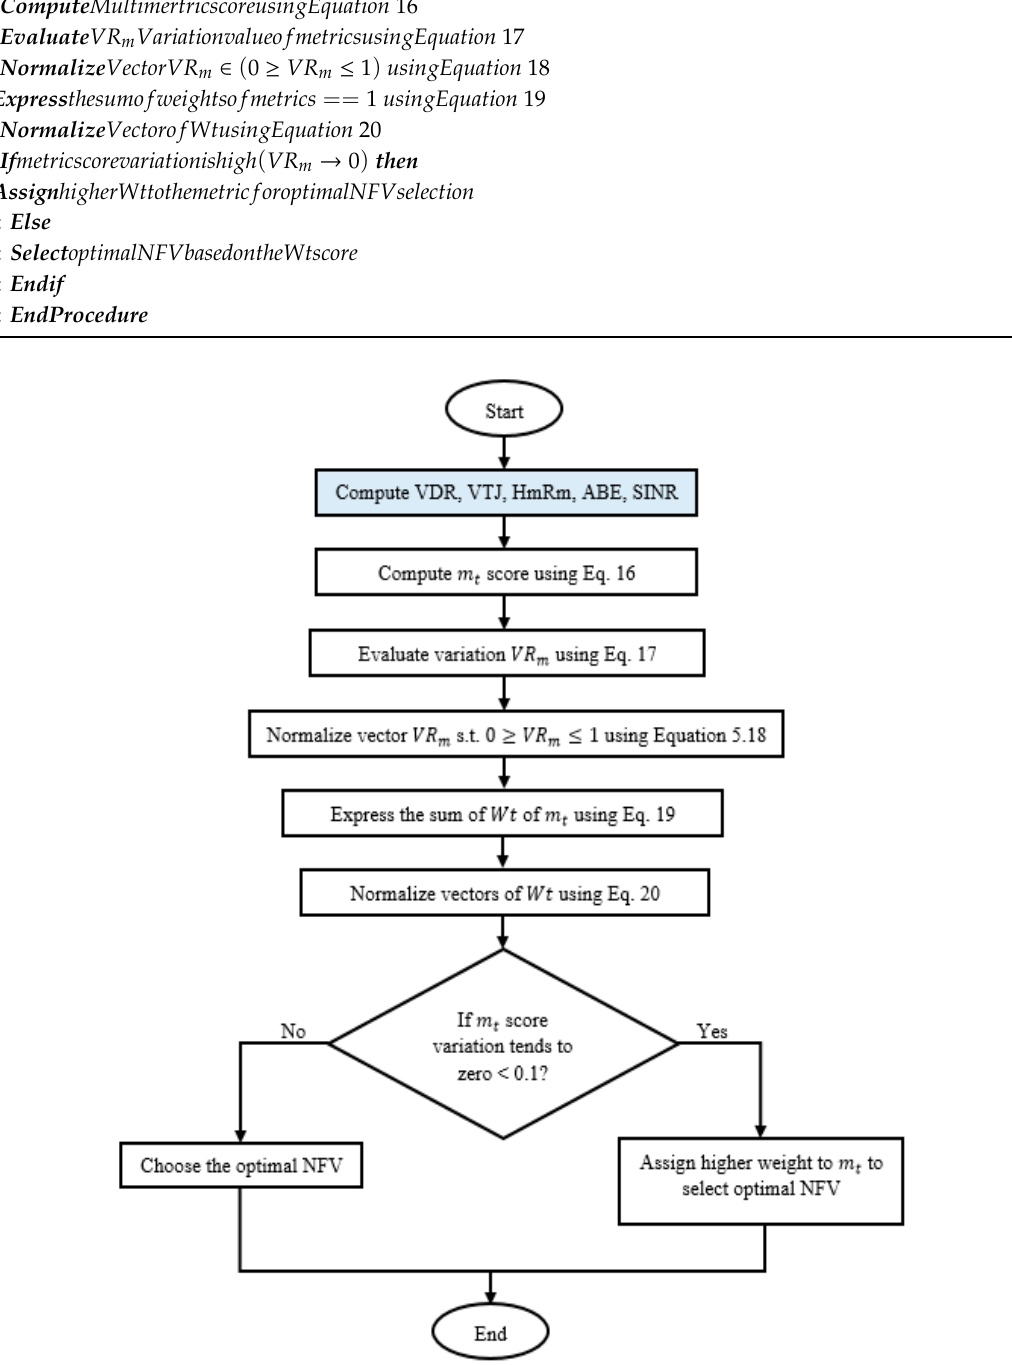
Figure 4. Dynamic Self-Weighting Score Flowchart.